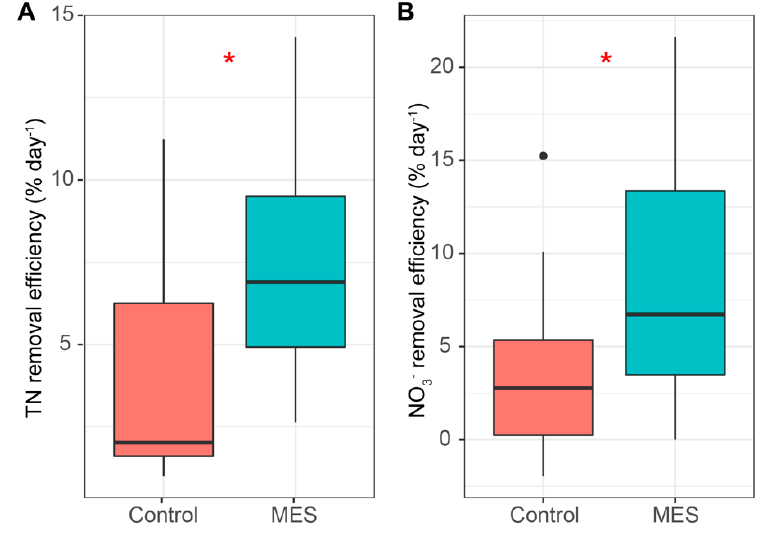
Figure 4. Total nitrogen ( A ) and NO 3 ‾ ( B ) removal efficiencies per day (% day − 1 ). Median, min/max, 25% and 75% quartile values are presented. The asterisks denote statistically significant differences between the MES and control reactors * p < 0.05.